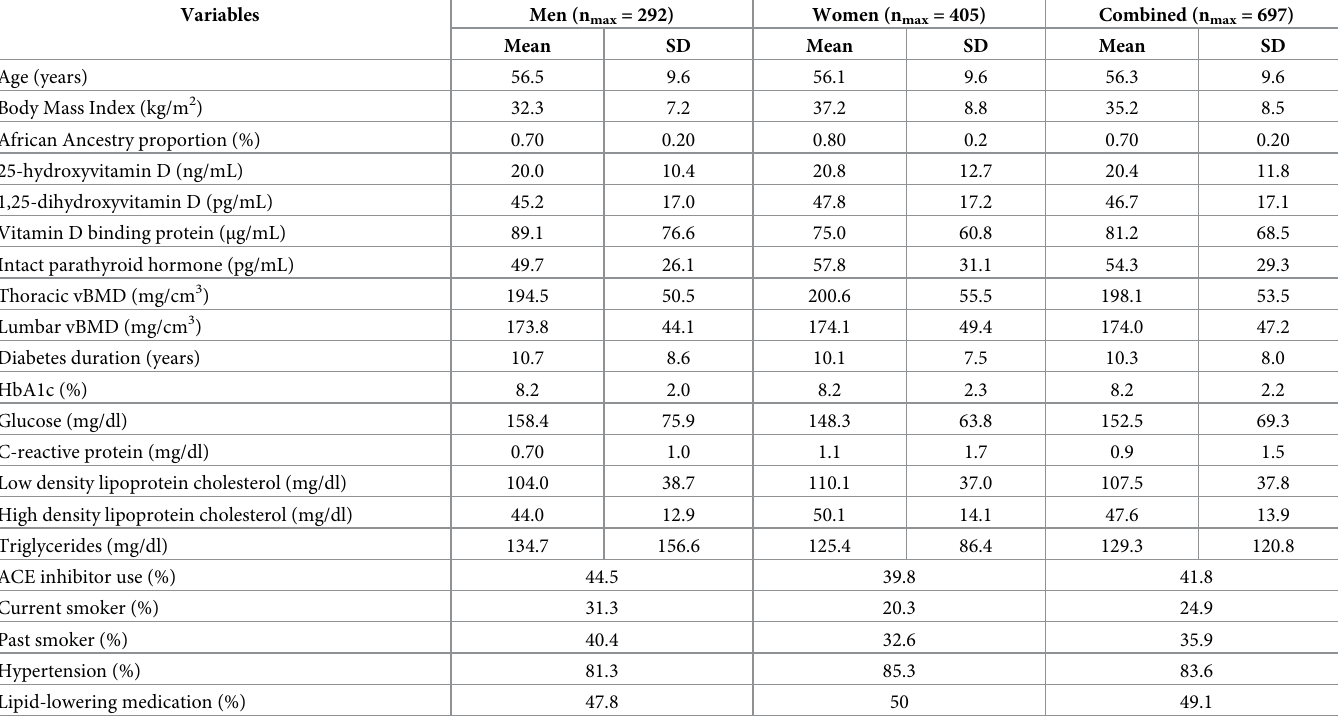
Table 1. Demographic, laboratory, and imaging characteristics of the African American-Diabetes Heart Study cohort.